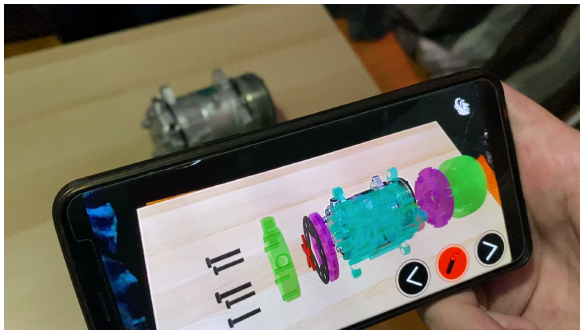
Figure 6. Exploded view diagram generated by MARS. The illustration contains the designed subparts of the compressor in the explosion